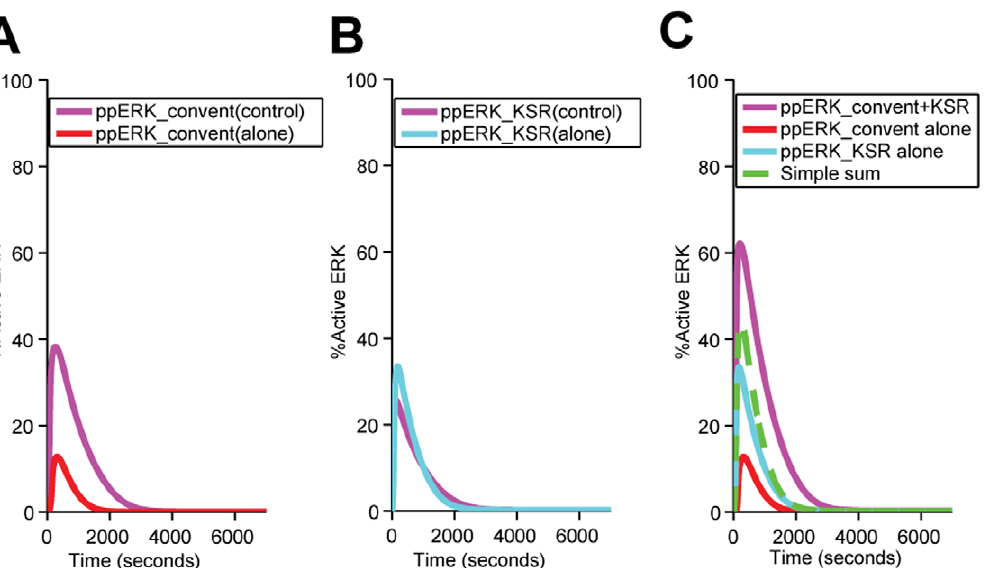
Figure 8. The synergistic effect of the two membrane associated signaling components, the conventional EGFR–Ras–Raf–MEK–ERK signaling module (Convent) and the KSR-mediated module (KSR) on ERK activation.